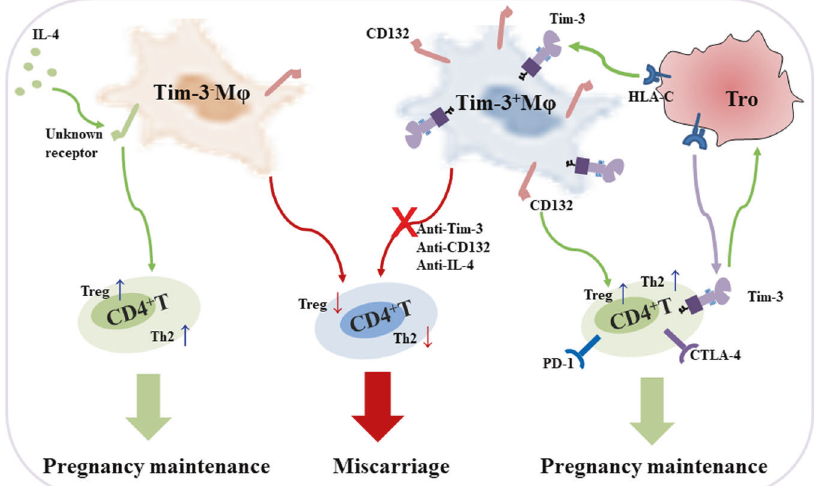
Fig. 8 Schematic diagram of functional regulation of Tim-3 + M φ s on maternal-fetal tolerance. Previously we reported that Tros directly contributed to the Tim-3, PD-1 and CTLA-4 expression on dCD4 + T cells. These checkpoint pathways, in turn, may operate within the functional immune-modulatory network not only to promote maternal-fetal tolerance but also improved Tros function. The current study demonstrated that Tros also induced the higher Tim-3 expression on dM φ s during normal pregnancy in HLA-C dependent manner. Neither Tim-3 + nor Tim-3 − dM φ s population can be categorized as strictly M1 or M2. With higher CD132 expression, Tim-3 + dM φ s induced Th2 and Treg bias in dCD4 + T cells and promoted pregnancy maintenance. The reduced abundance of Tim-3 on M φ s was accompanied by disordered anti- and pro-in fl ammatory cytokine pro fi les in miscarriage. Blockade of Tim-3 or CD132 pathways leaded to the dysfunction of maternal-fetal tolerance and increased fetal loss. While IL-4 treated Tim-3 − M φ s, via unknown receptor, could rescue the fetal resorption induced by M φ